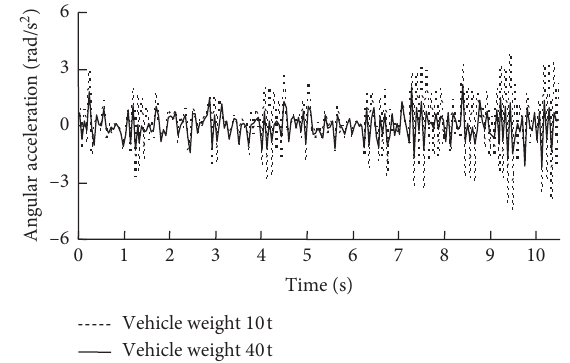
Figure 23: The time-history curves of pitching vibration accel- erations of the vehicle